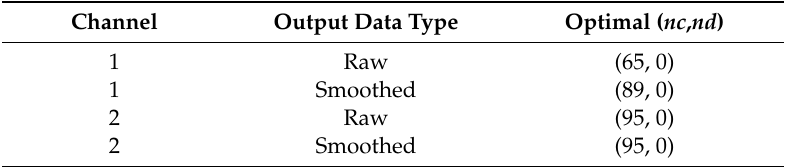
Table 4. Optimal structural indices for ARMA models on both channels, in case of two-step optimization strategy.